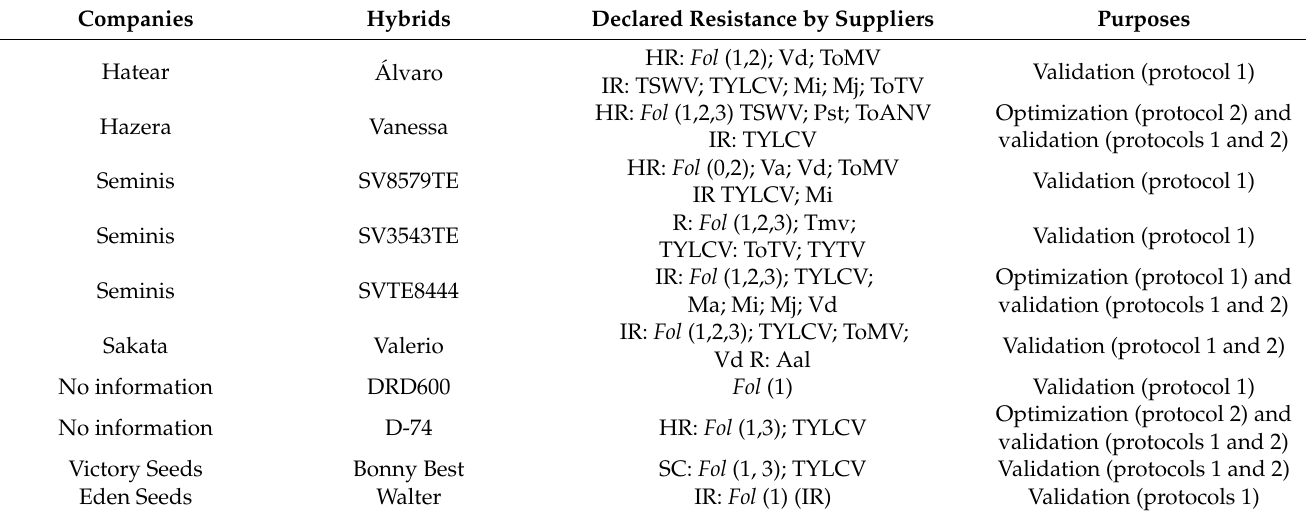
Table 1. Commercial and non-commercial tomato materials used in this study.